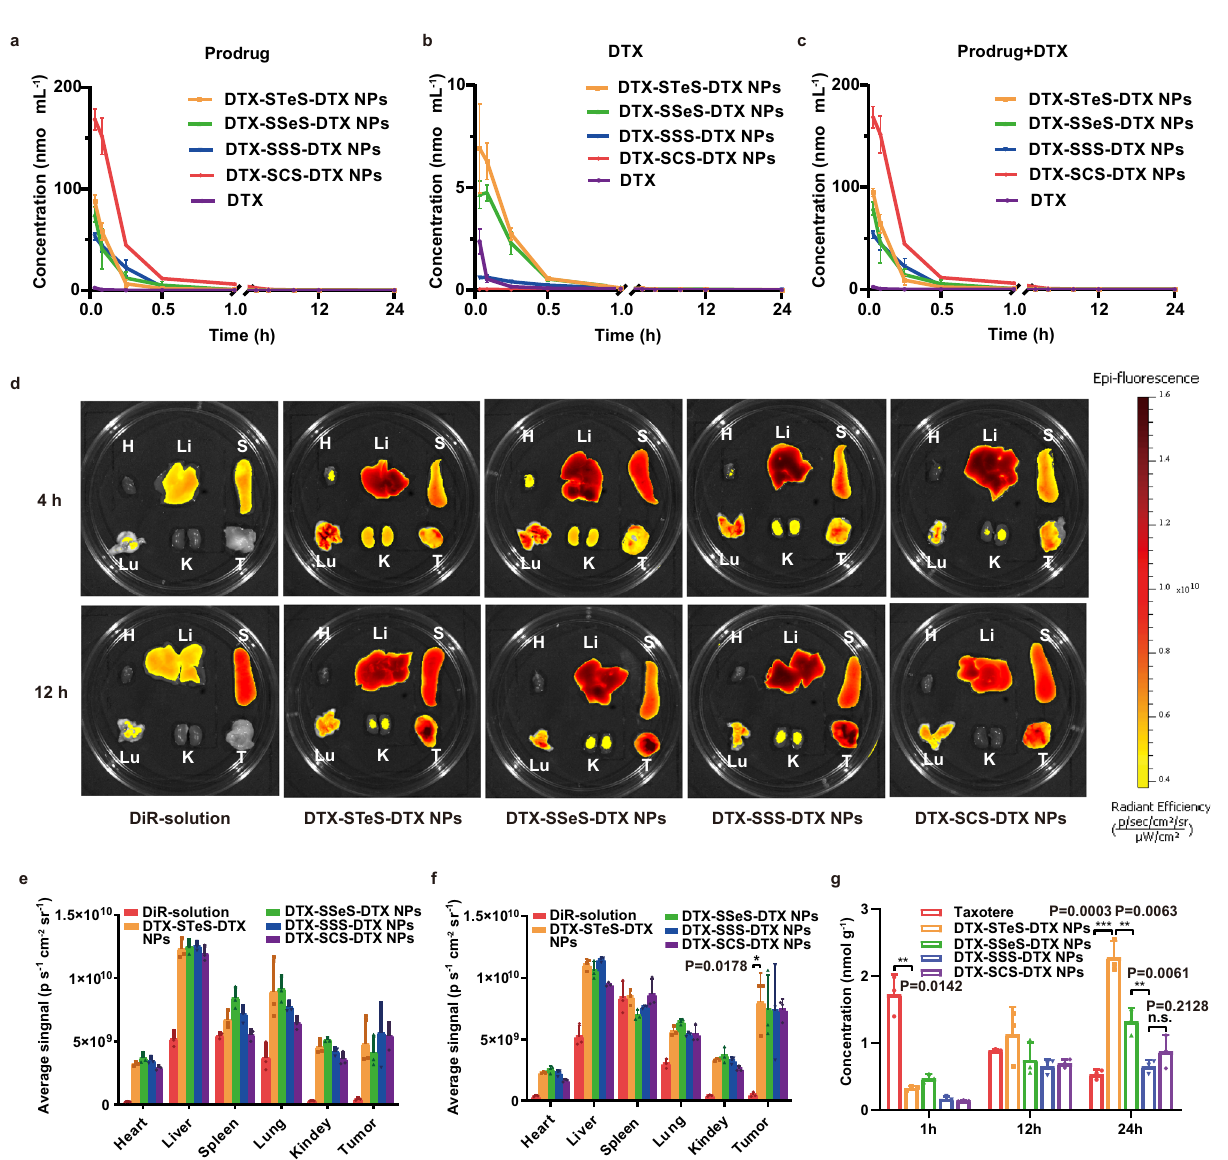
Fig. 5 | Cytotoxicity and intracellular bioactivation. a – d IC 50 values of Taxotere and HPNAs in 4T1 cells, B16F10 cells, Hepa 1 – 6 cells, and 3T3 cells. All data are presented as mean±SD ( n =3 independent experiments). n.s. (no signi fi cance) P >0.05,* P <0.05,** P <0.01,*** P <0.001and**** P <0.0001bytwo-tailedStudent ’ s t -test. Source data are provided as a Source Data fi le. e Cellular uptake of free coumarin-6 or coumarin-6-labeled HPNAs at 2h. Scale bar represents 10 μ m. Experiment was repeated twice independently with similar results. f Results of cell uptake by fl ow cytometry. Data are presented as mean±SD ( n =3 independent experiments). One-way ANOVA (one-sided) with Dunnett ’ s multiple comparisons